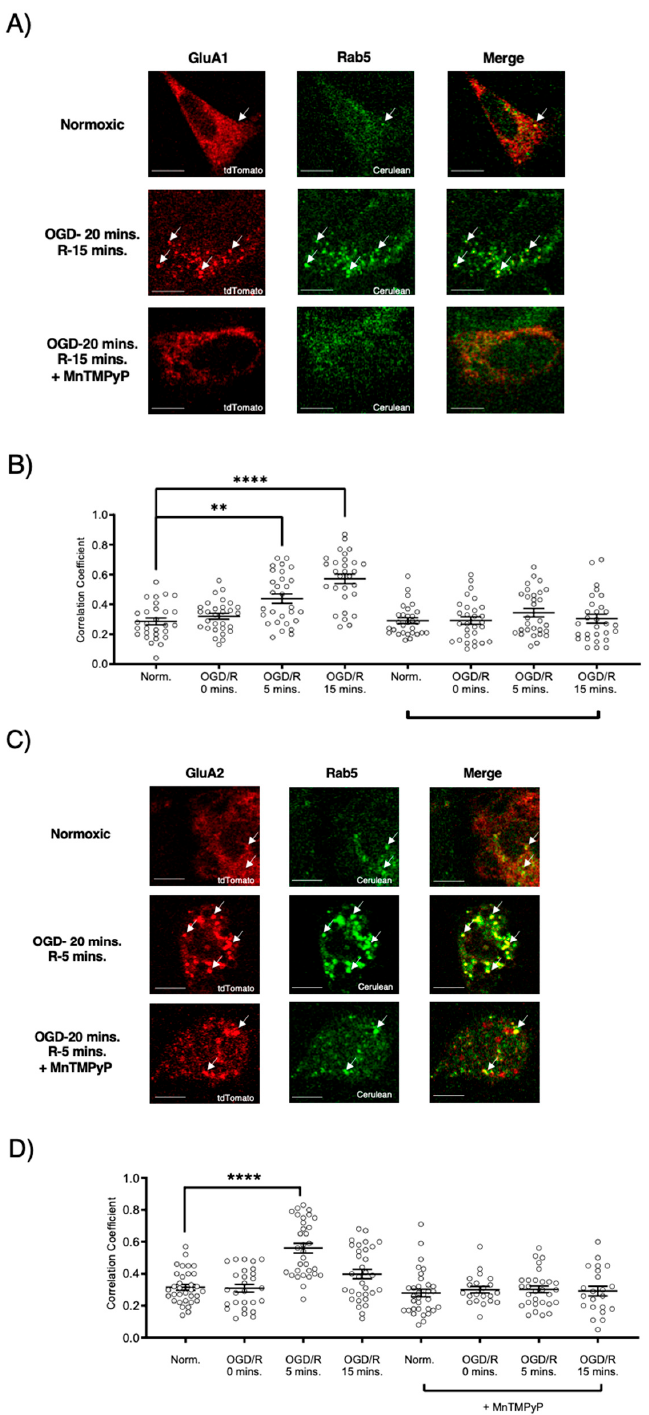
Figure 4. MnTMPyP prevented OGD/R-induced internalization of GluA1 and GluA2 AMPAR subunits. U-251 MG cells transfected with either GluA1-tdTomato or GluA2-tdTomato, and Rab5-cerulean, an early endosomal marker, and exposed to either normoxic or OGD/R conditions. ( A ) Increased colocalization between GluA1 and GluA2, indicating internalization, maximally at OGD/R-15 min; the effect was ameliorated with pretreatment of MnTMPyP, a superoxide scavenger. ( B ) Quantification of ( A ) microscopy (n = 30). ( C ) Increased colocalization between GluA2 and Rab5, indicating internalization, maximally at OGD/R-5 min; the effect was ameliorated with pretreatment of MnTMPyP. ( D ) Quantification of ( C ) microscopy results (n = 30). ** p < 0.01; **** p < 0.0001; ANOVA with Tukey’s post hoc test comparing OGD/R conditions to the corresponding control (normoxic ± MnTMPyP). Data are expressed as mean ± SEM. Scale bar is 100 µ M. Arrows indicate